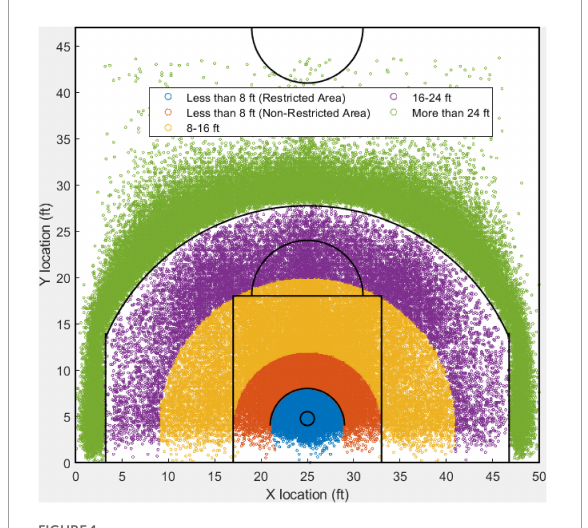
FIGURE1 An illustrative example of field goals from five different shooting distances based on the NBA regular season 2020–2021.